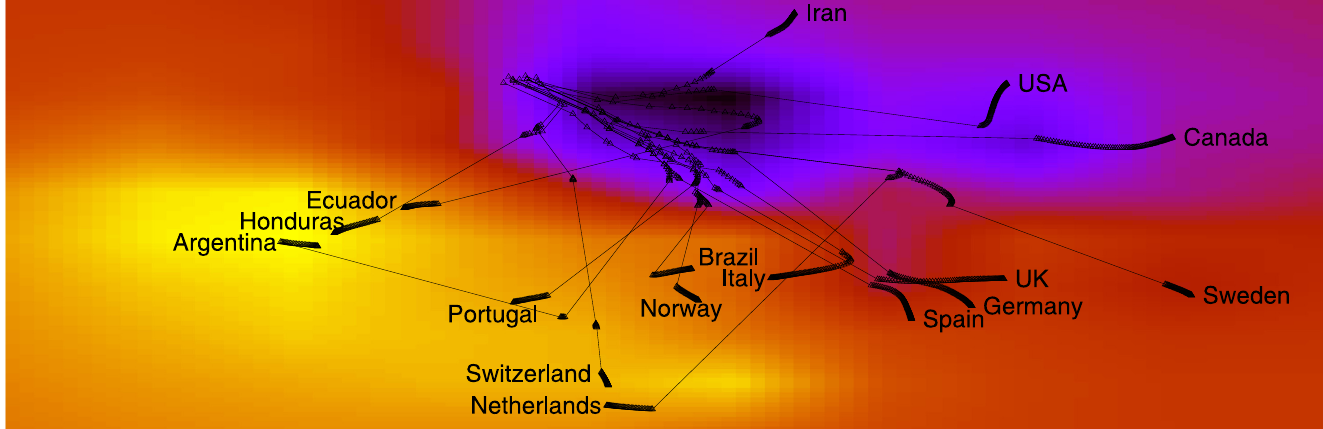
Fig 4. (Color online) Countermeasures adopted by each country forms a trajectory. The heatmap is built by taking into account all the 211 considered countries.